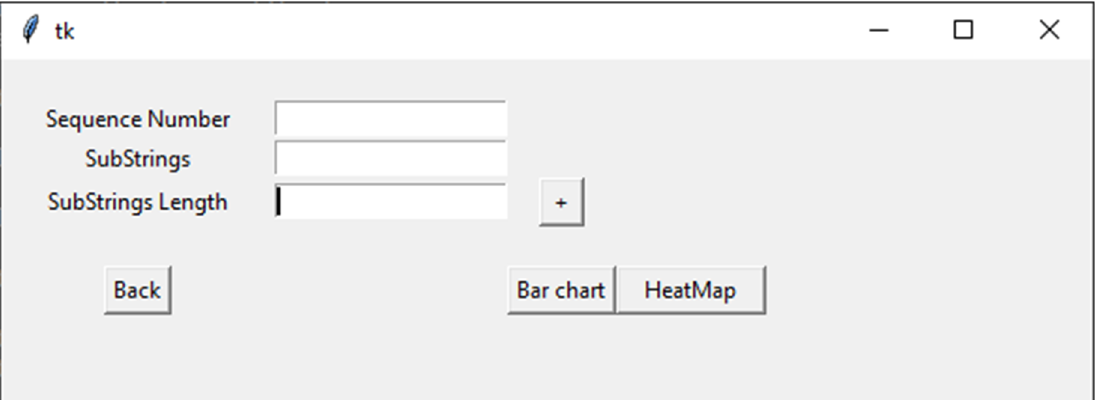
Figure 2. An overview of the plotting options in VIRMOTIF.